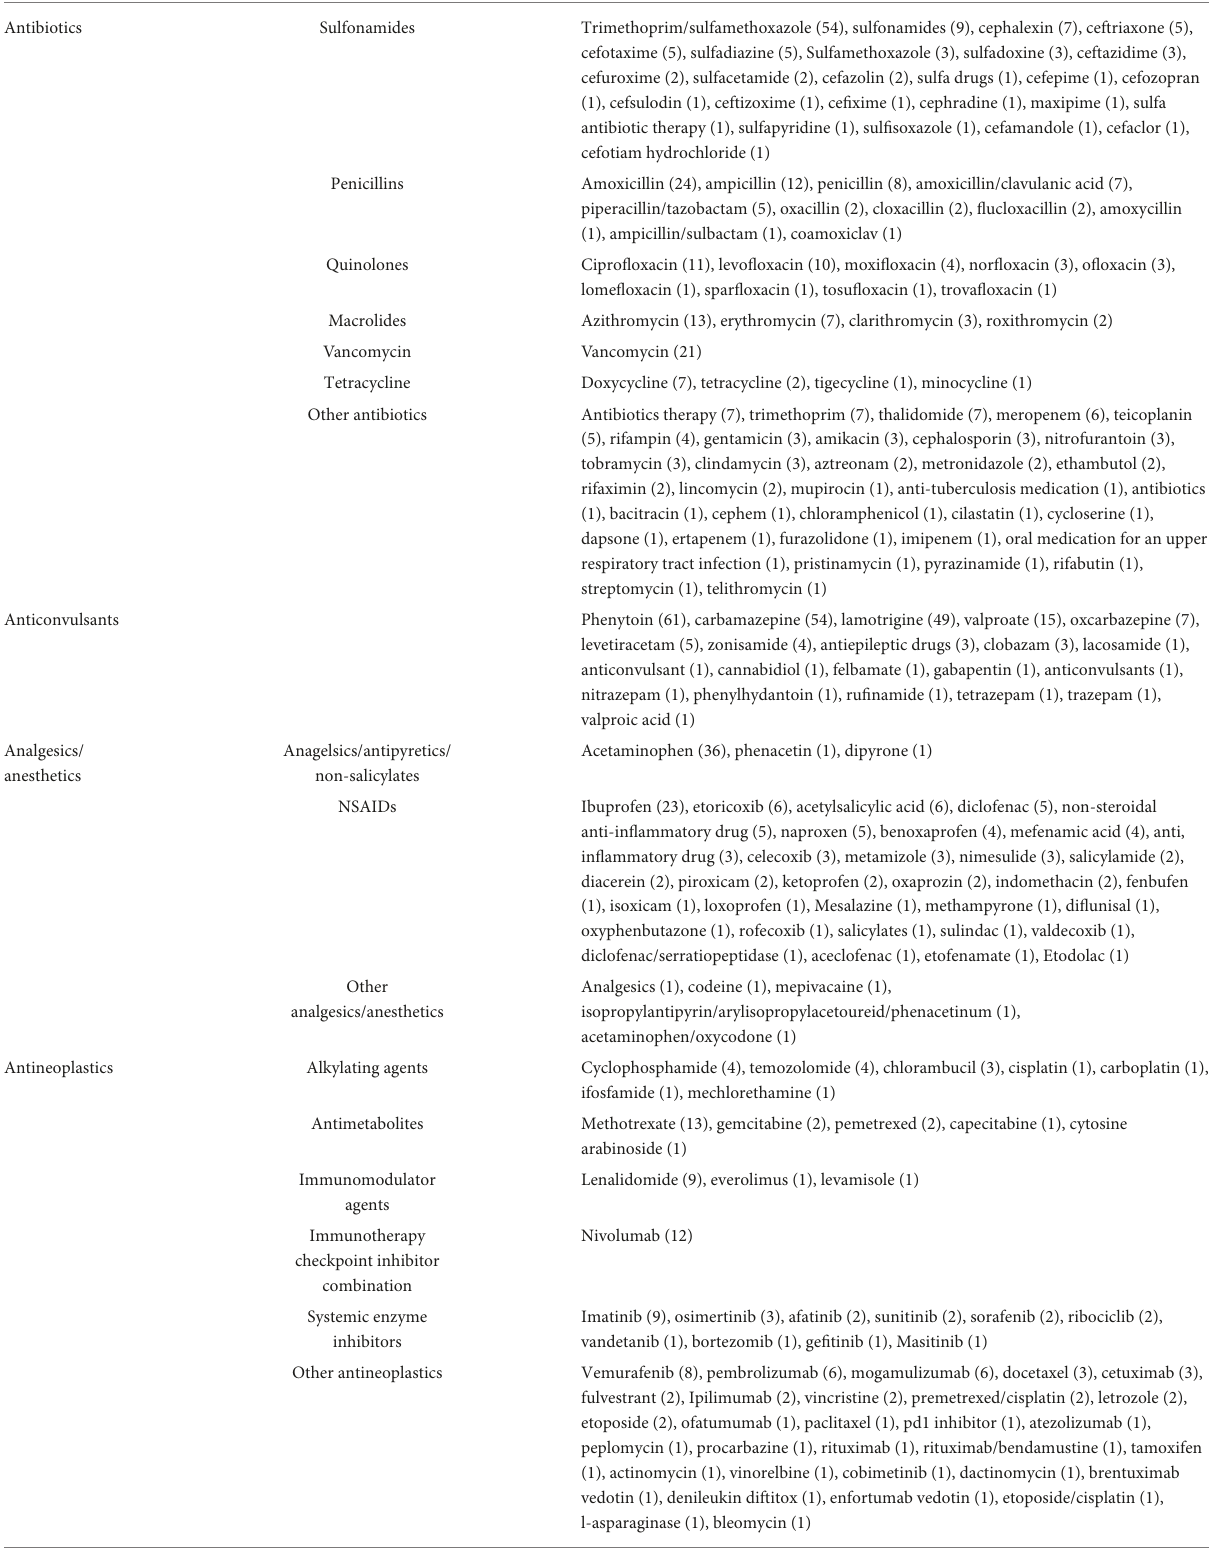
TABLE 5 Drug category, drug type, and allergen with case count. Drug